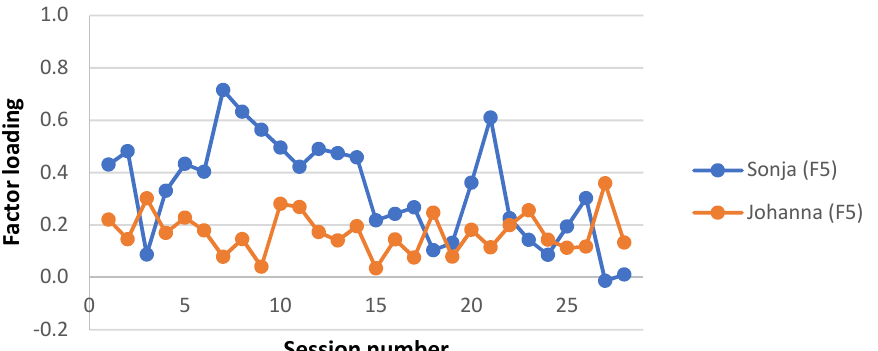
Figure 5. Interaction structure 5; “Working with low mentalization”. Factor loadings on each session for Sonja and Johanna.